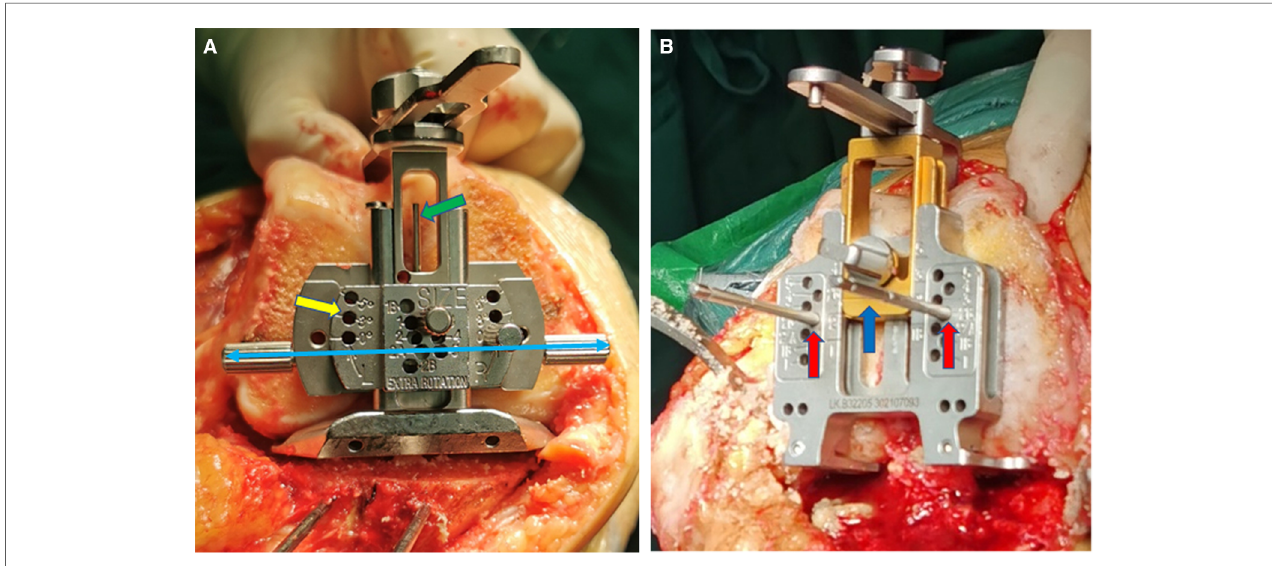
FIGURE 3 Femoral sizing and rotational positioning ( A for MA; B for KA). ( A ) Standard MA rotational positioning device. The measured resection technique was applied for the external rotational positioning in the distal femur depending on Whiteside line (green arrow), transcondylar line (blue double arrow), or setting to 3° external rotation (yellow arrow). ( B ) Femoral sizer and positioning device of the speci fi c KA instrument. Place the femoral sizer against the resected surface of the distal femur with the posterior feet of the sizer contacting the posterior condyles. The gold slider (blue arrow) is used to size the femur, and the pairs of pin holes (red arrow) on the silver component are posterior reference design parallel to the PCA to ensure an equal resection of the posterior